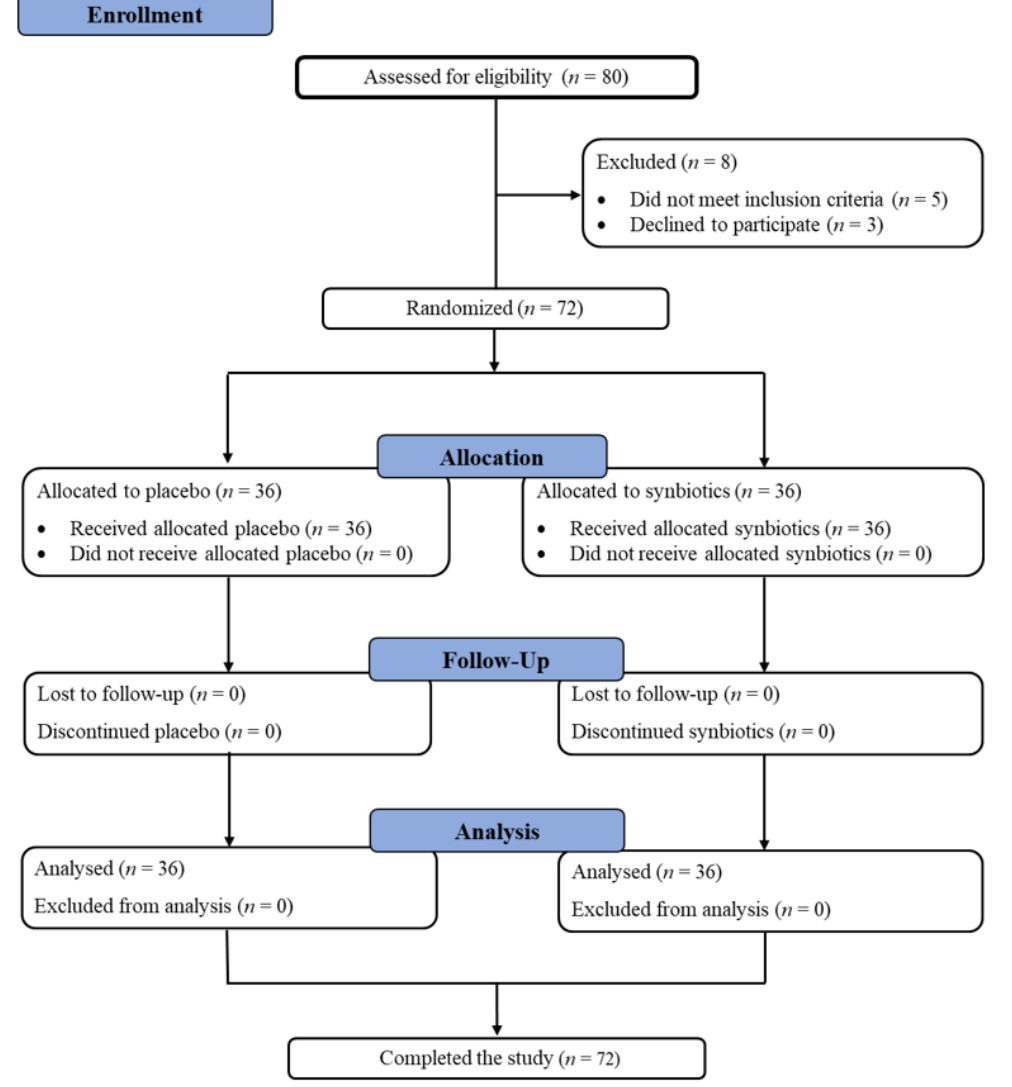
Figure 1. The study flowchart and